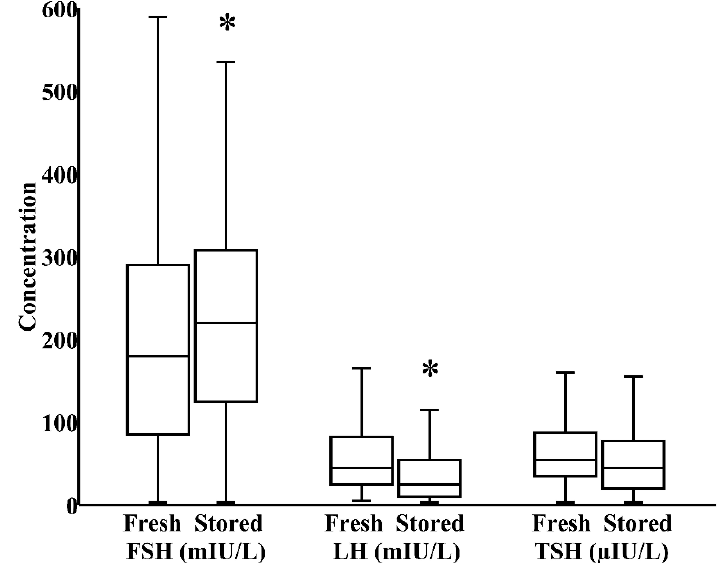
Figure 2. Impact of 24 h refrigerated storage on the concentrations of FSH, LH, and TSH in a combined cohort of freshly pasteurized donor and freshly pumped maternal milk ( N = 57). * p < 0.05 versus fresh milk.